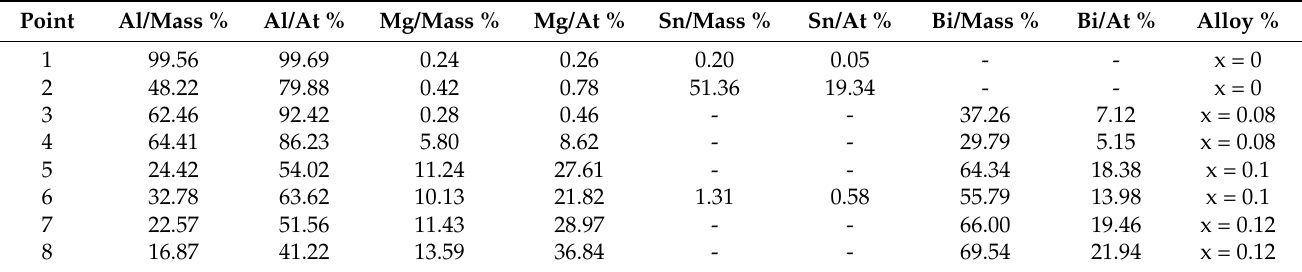
Table 2. The EDS analysis results of the precipitated phases of the Al-Mg-Sn-Ga-xBi